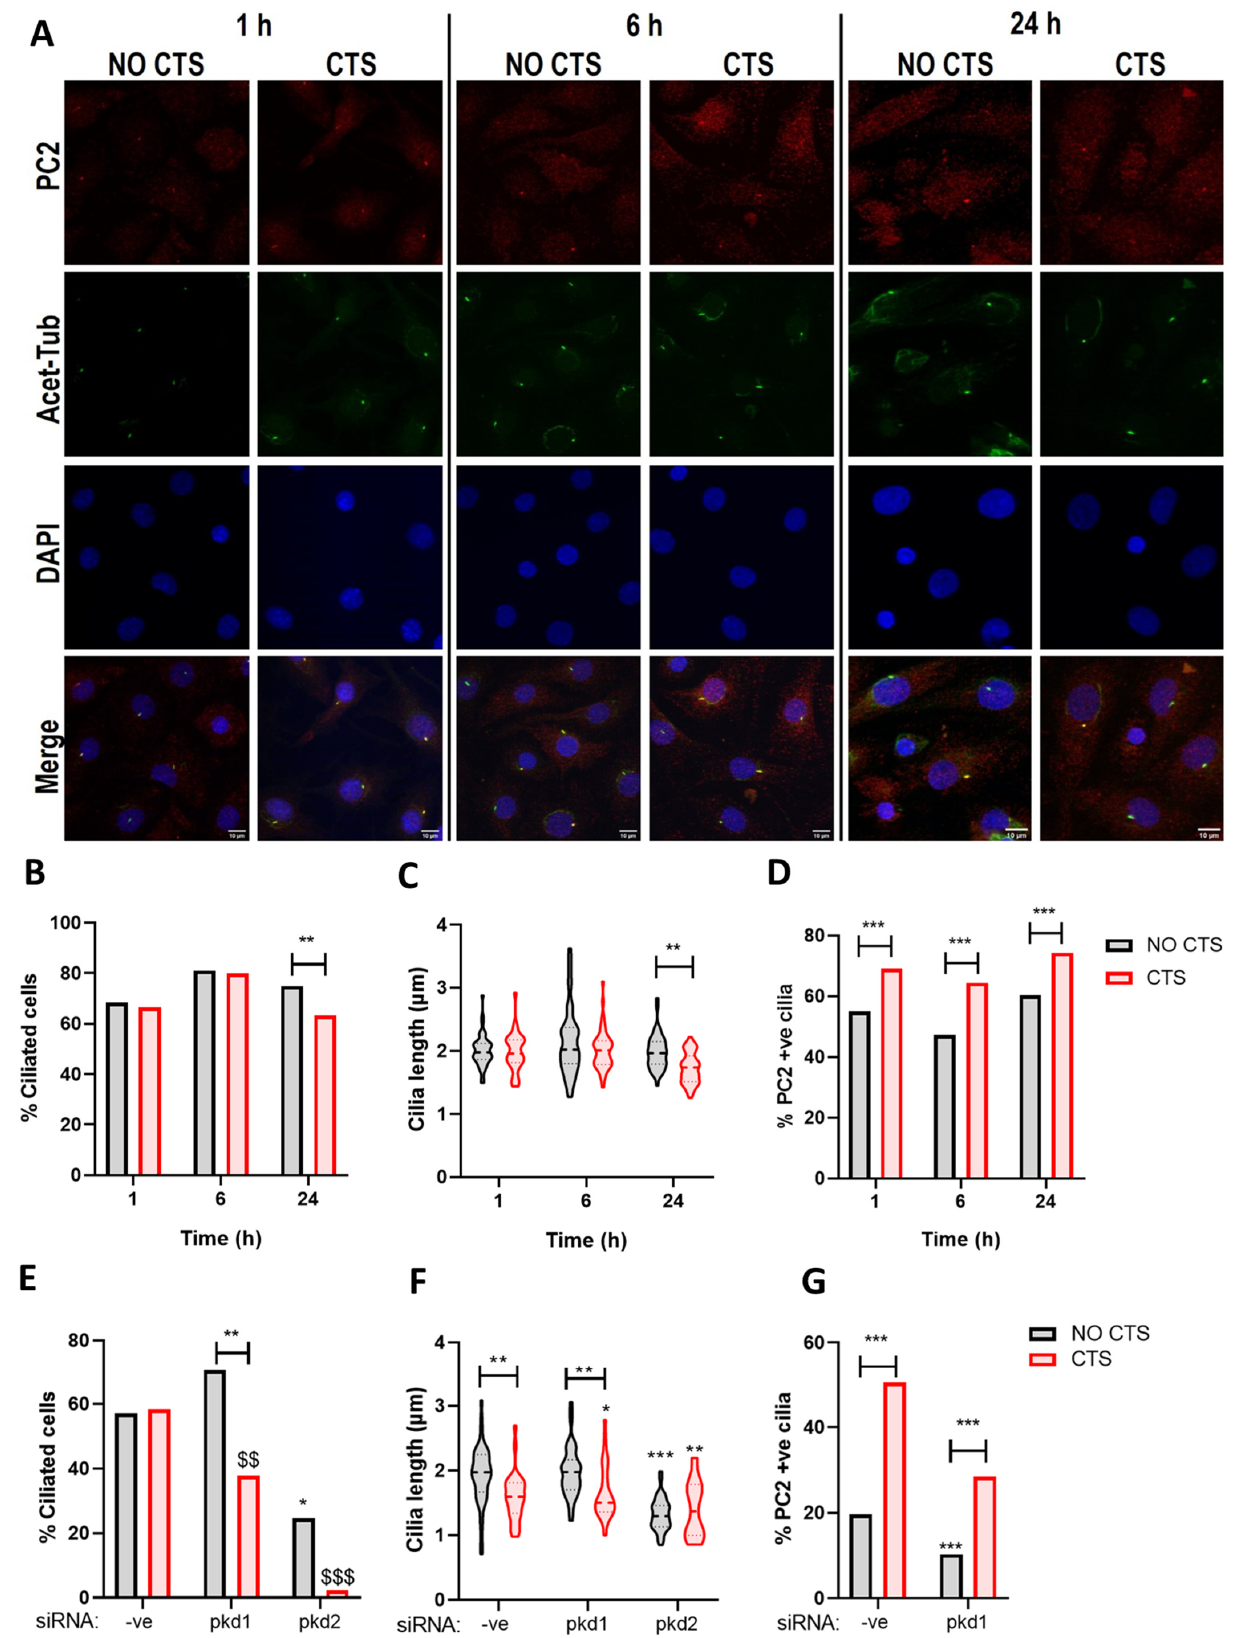
Figure 4. Polycystin-2 ciliary localization is increased in response to strain. Bovine articular chondrocytes were cultured on elastomeric membranes and subjected to 10% cyclic tensile strain (CTS) for 1, 6, and 24 h at 0.33 Hz. ( A ) Chondrocytes